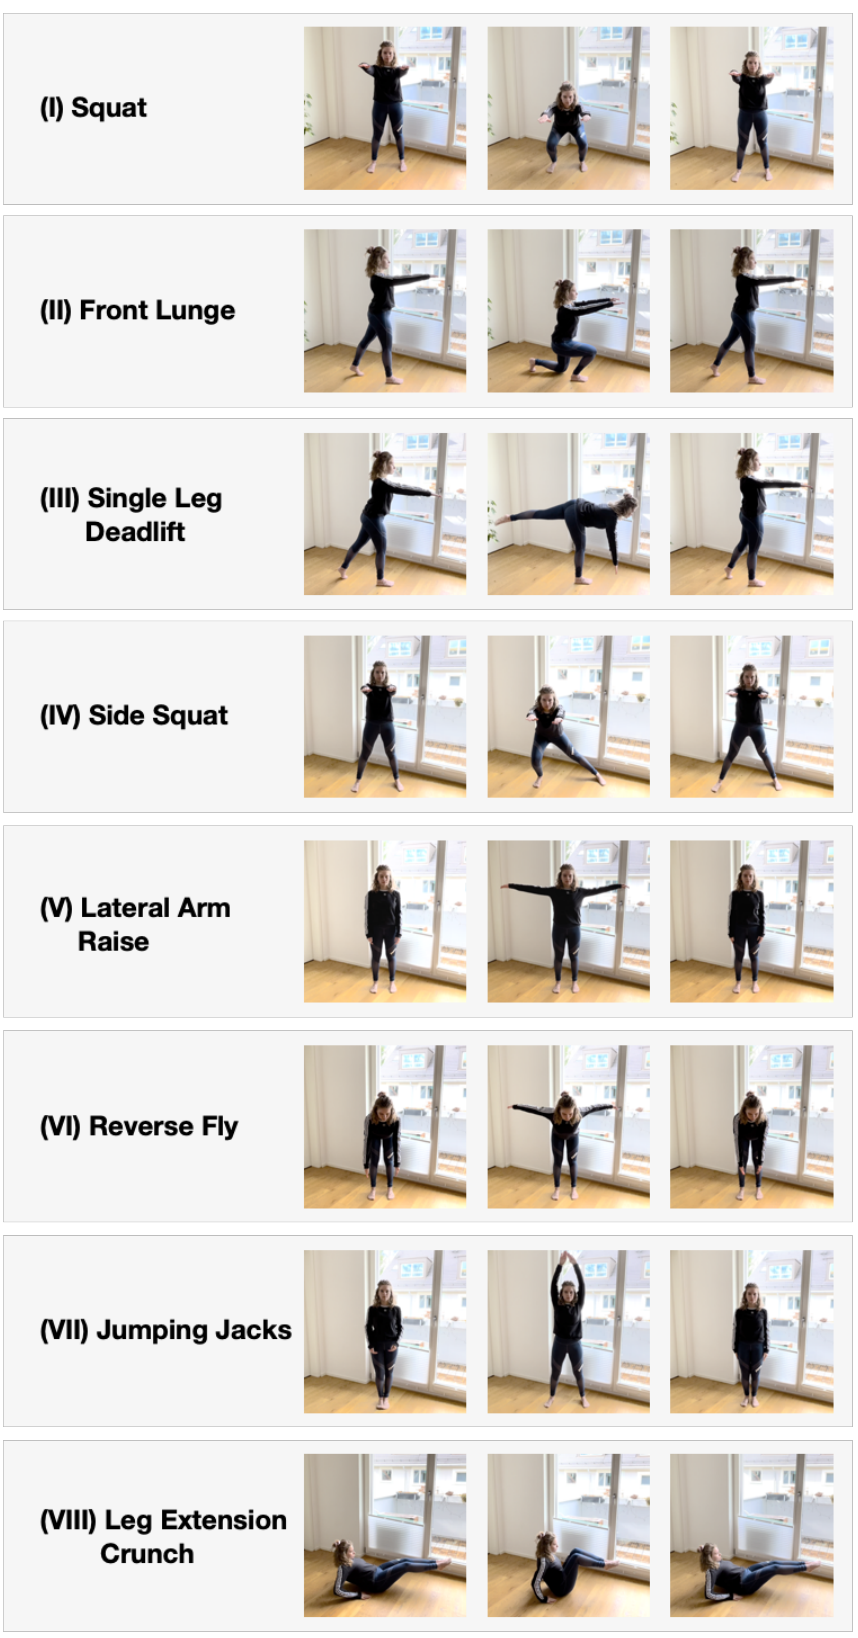
Figure 1. The execution of all eight exercises as seen from the frontally positioned iPad. The body orientation was chosen to maximize the visible parts of the